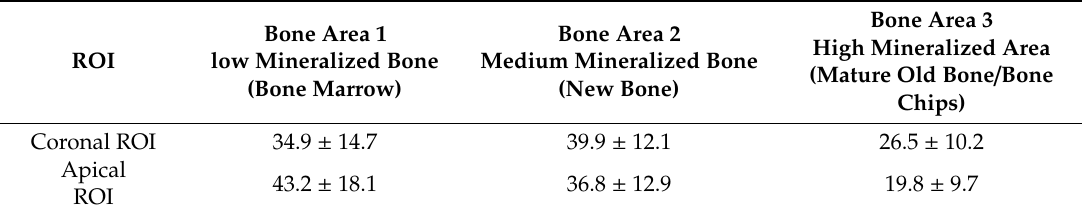
Table 3. Type of bone areas measured at ROI (Mean % ± SD) n = 8 implants. No statistically significant differences were reported among coronal and apical ROI (p < 0.05) .